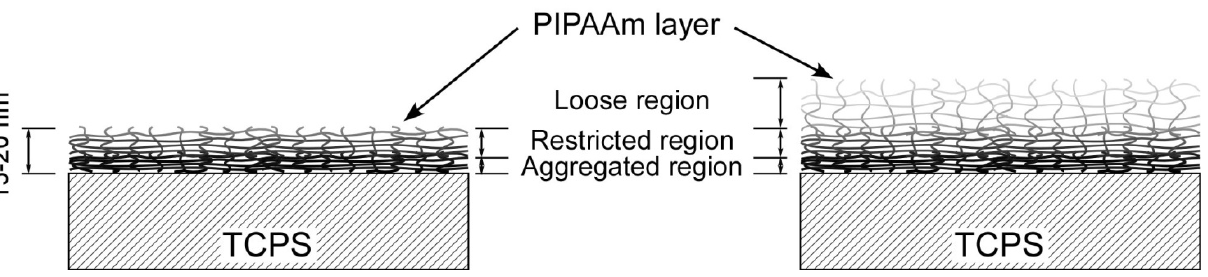
Figure 2. Schematic illustration of the effect of molecular mobility of grafted PIPAAm chains on its adhesion characteristics at 37 °C. The grafted PIPAAm gels are thin (the left side) and thick (the right side). The darker chains denote more restricted molecular motion, while brighter chains suggest greater mobility. The darker and lighter chains show a firmly and loosely restricted molecular motion,